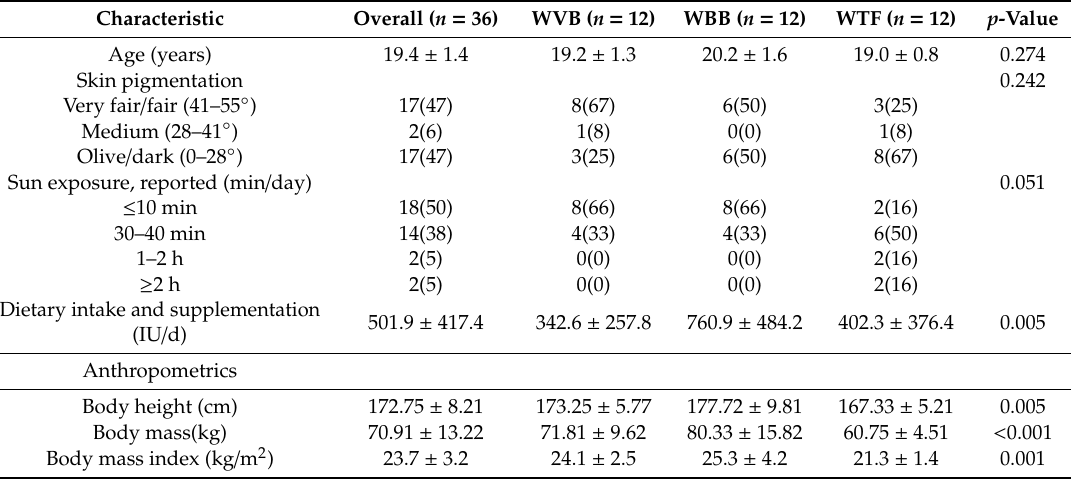
Table 1. Characteristics of